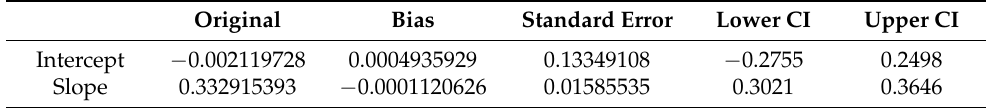
Table 4. Bootstrap statistics (100,000 replicates) for best overall regression model. CI = 95% confidence